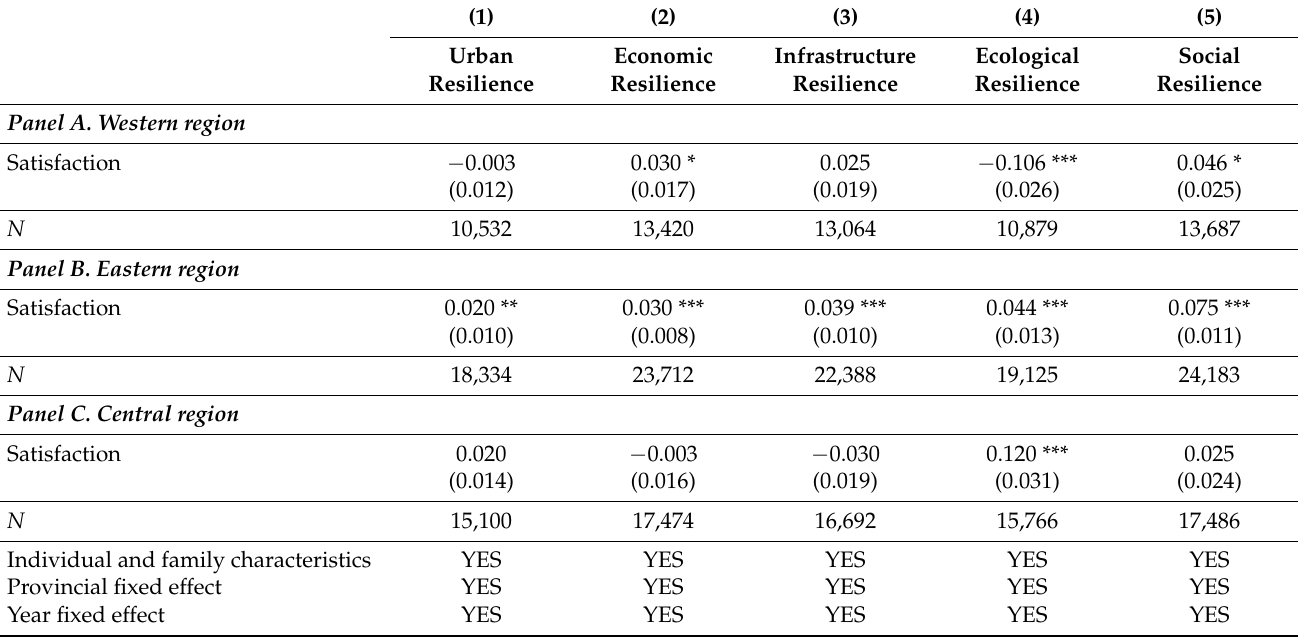
Table 7. Effect of urban resilience on residents’ subjective happiness by